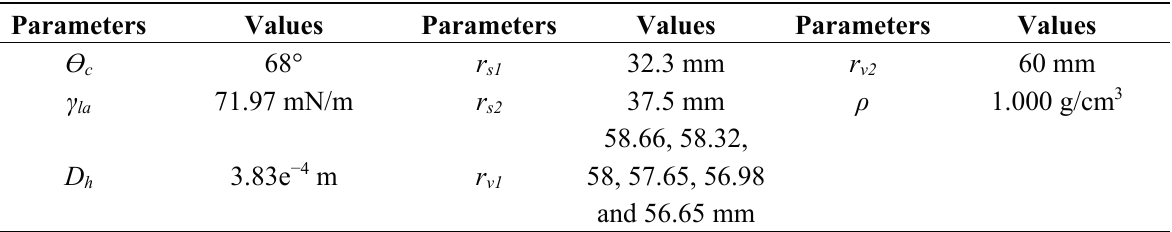
Figure 3. Pressure balance at different venting chamber liquid heights for a range of spinning speeds. Table 1. Values of the parameters implemented in the analytical calculations.